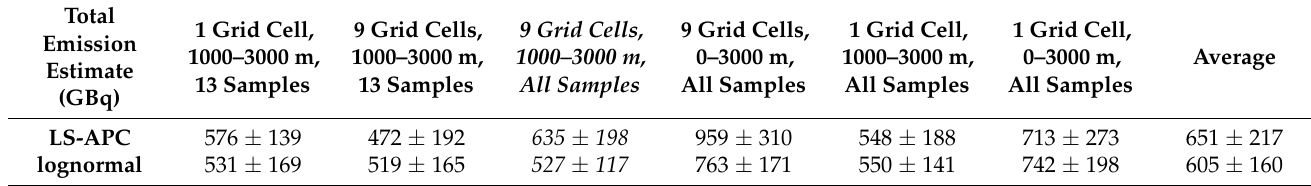
Table 2. Emission estimates together with errors in Gigabequerel (GBq) (1 GBq = 1 × 10 9 Bq) for the two different approaches, different assumed source locations, and a different number of involved samples. The LS-APC and lognormal reference results are marked in